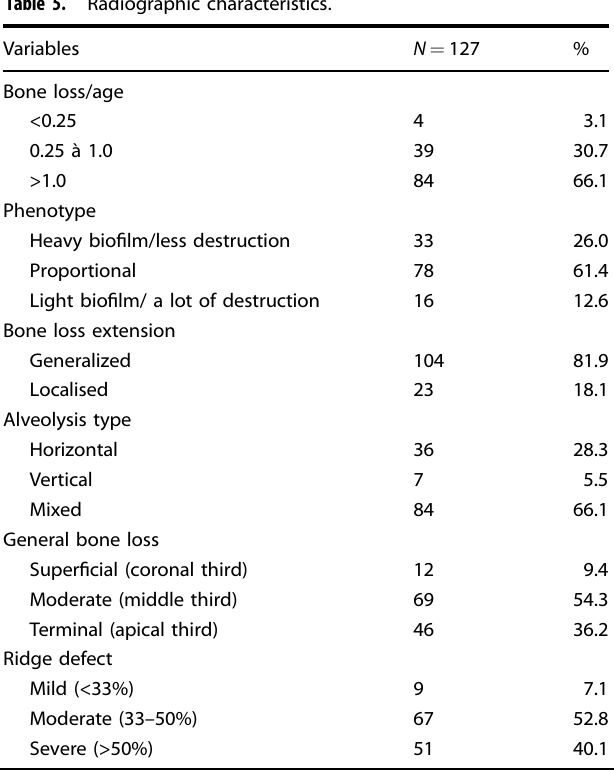
Fig. 3 Clinical features. Showing main clinical characteristics distribution of the study population. Table 5. Radiographic characteristics.